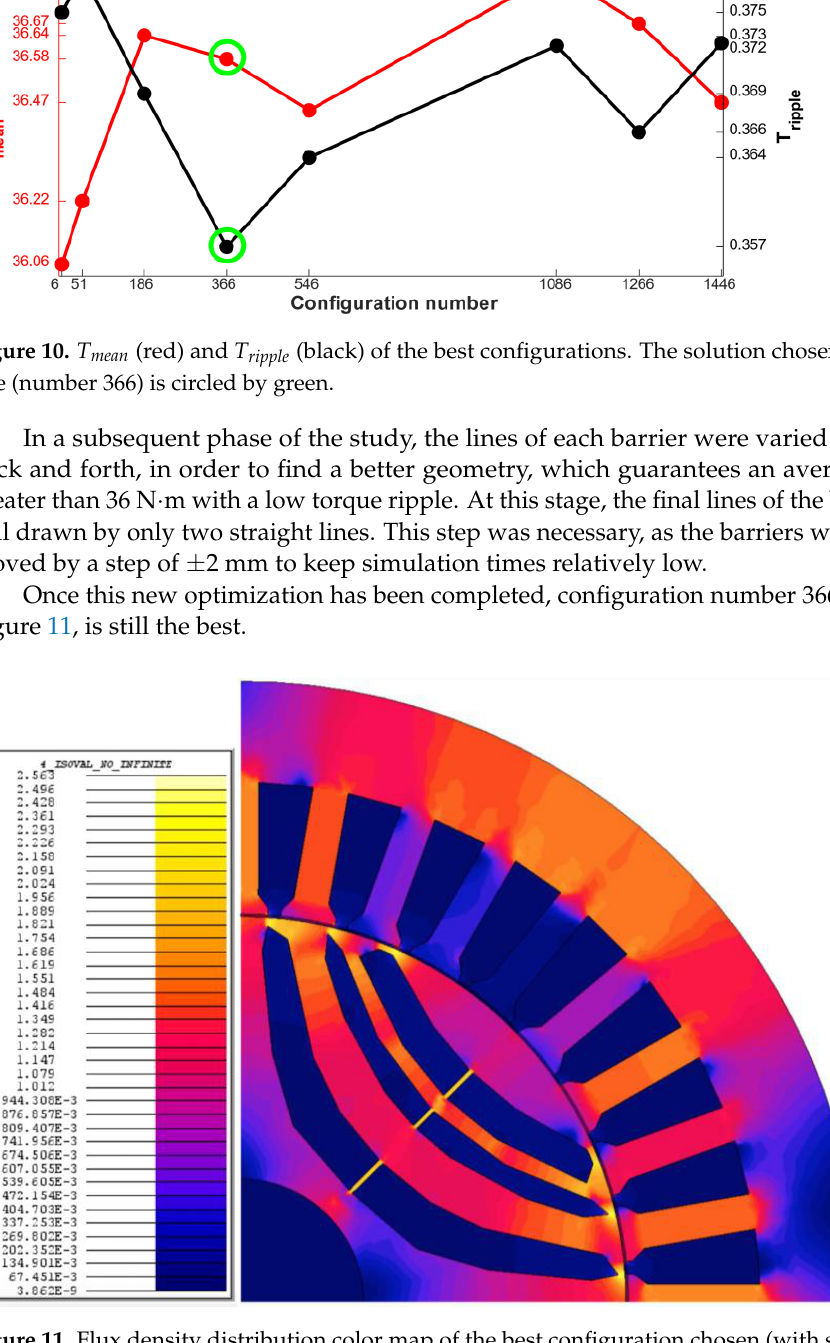
Figure 10. T mean (red) and T ripple (black) of the best configurations. The solution chosen as the best one (number 366) is circled by green.